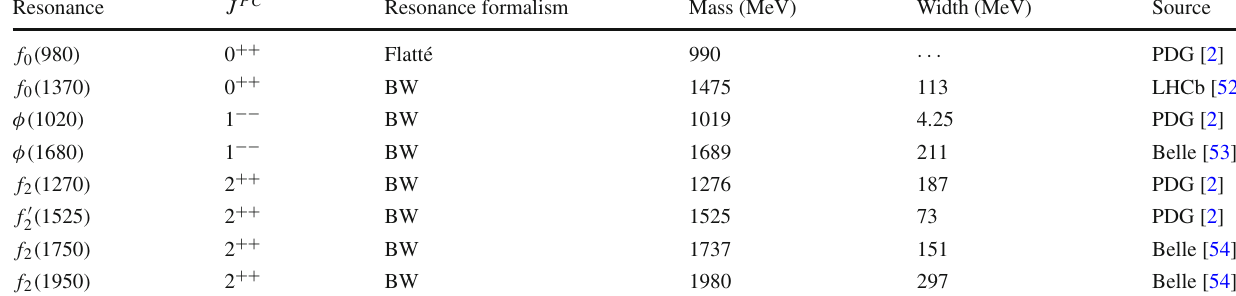
Table 1 The relevant resonance parameters in the B s → XK + K − decays